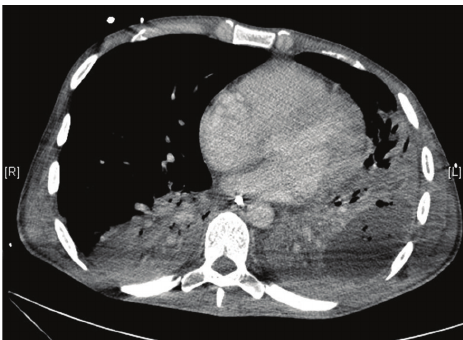
Figure 1: Thoracic CT scan revealing a voluminous lung abscess on the left pulmonary upper lobe on hospital day